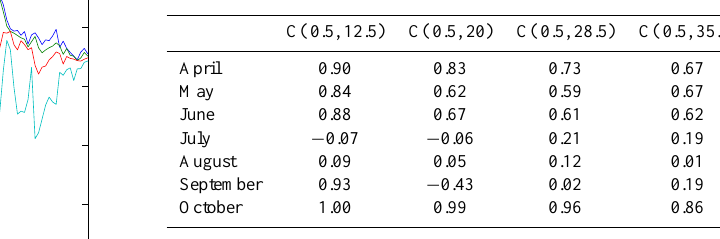
Table 2. Correlation coefficients of observed sea temperatures cal- culated by grouping data monthly. Correlations between the surface measurement and the measurements at 12.5, 20, 28.5 and 35.8m are shown in columns 2 to 5,